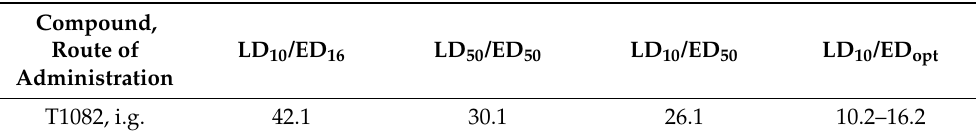
Table 2. Pharmacological safety indicators of T1082 radioprotective action in mice after intragas- tric